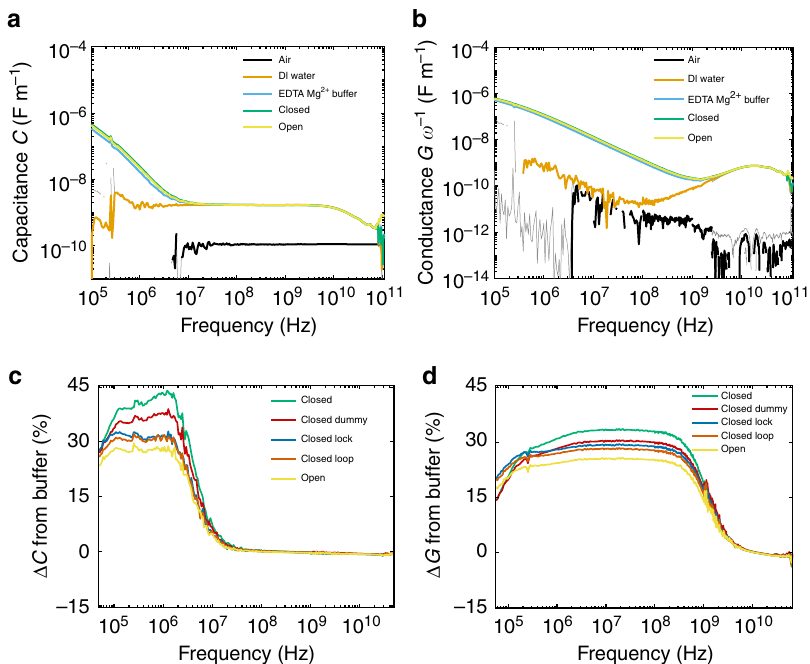
Fig. 3 Calibrated a distributed capacitance C tot and b distributed conductance G tot ω − 1 for air, DI water, TAE-Mg 2 + buffer, closed DNA tweezers, and open DNA tweezers. Lighter gray lines represent 95% con fi dence intervals (shown on all datasets). The percent change from TAE-Mg 2 + buffer for closed, open, and control tweezer samples for c distributed capacitance C tot and d distributed conductance G tot ω − 1 . Loop and Lock correspond to the additions of FUEL 1 and FUEL 2,